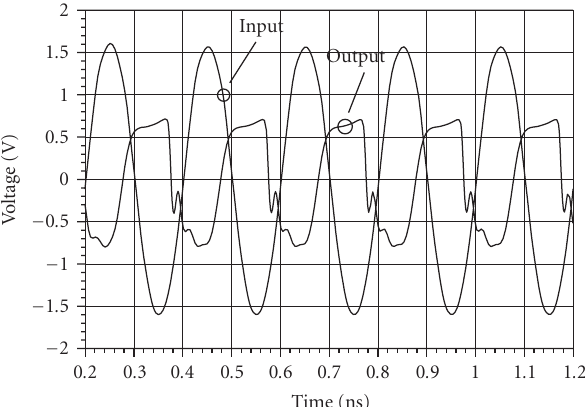
Figure 7: The simulated NLTL result with a 5 GHz, 1.6 V-amplitude input.